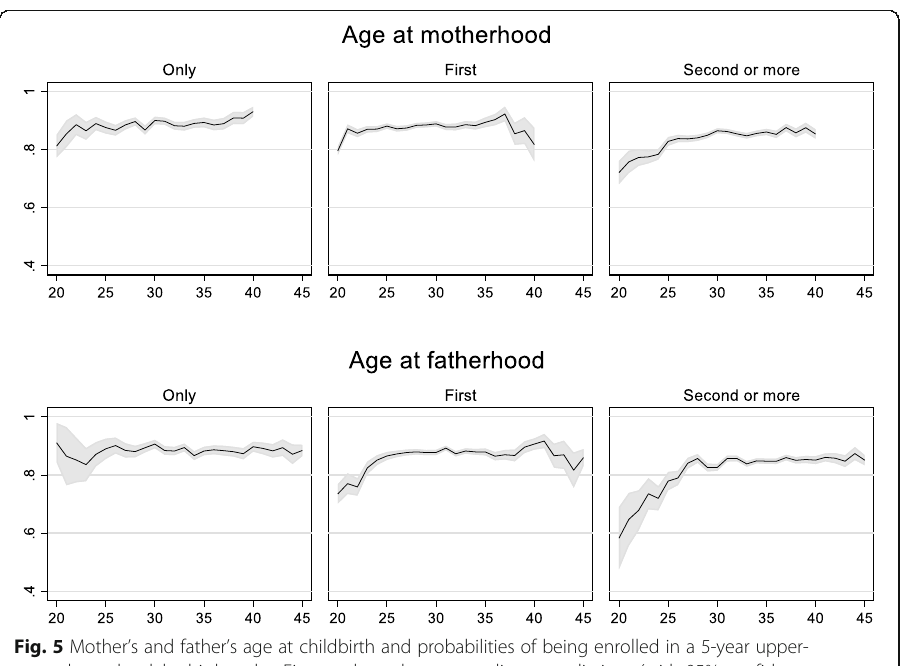
Fig. 5 Mother ’ s and father ’ s age at childbirth and probabilities of being enrolled in a 5-year upper- secondary school, by birth order. Figures show the average linear predictions (with 95% confidence intervals), from linear probability models with robust standard errors. Models control for both parents ’ social class and education, region of residence, trimester-year of interview, birth abroad, age and sex